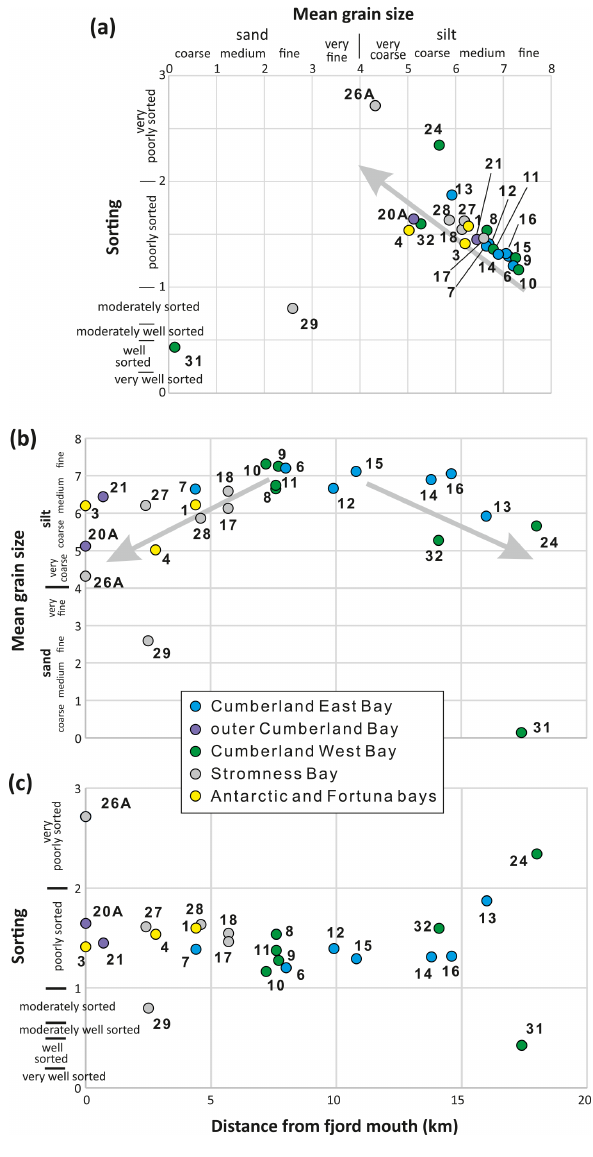
Figure 3. Sediment mean grain size vs. sorting expressed in phi scale (a) and the same parameters in relation to distance from fjord mouth (b,c) . Sediment categories are after Blott and Pye (2001). Note the trend line to coarser and less sorted sediments in panel (a) , two coarsening trends towards the fjord mouth and glacier front in panel (b) , and the presence of generally better sorted sediments in samples collected between 7 and 15km away from fjord mouth in panel (c)